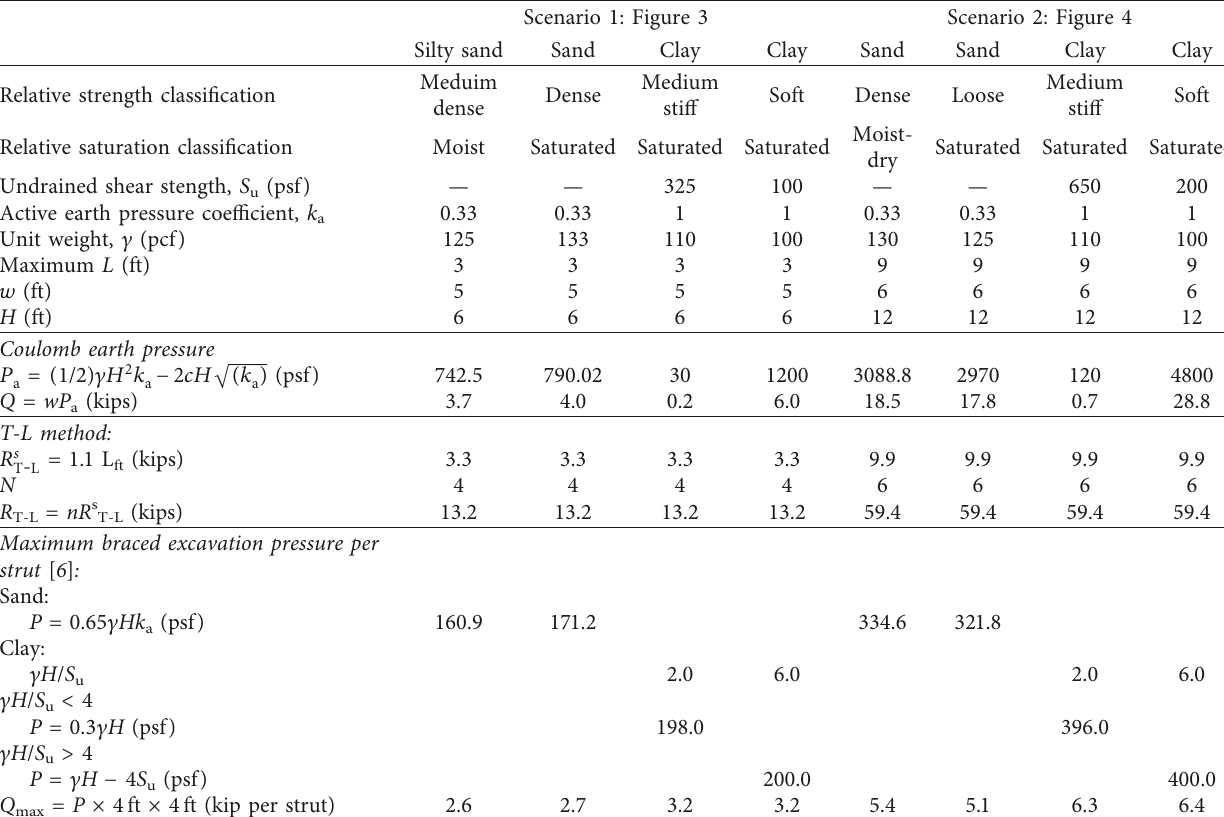
Figure 2: Spoil pile geometry at the angle of repose. The idealized geometry is conservatively used in the T-L method for calculation of surcharge loads. Table 4: Use of the T-L method for different failure scenarios. The clay properties bracket the range of plausible Type C clays that can exhibit the observed failure